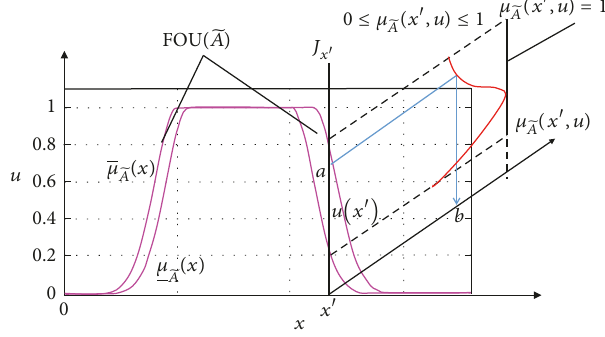
Figure 1: Expressing an IT-2FS and some relative aspects.